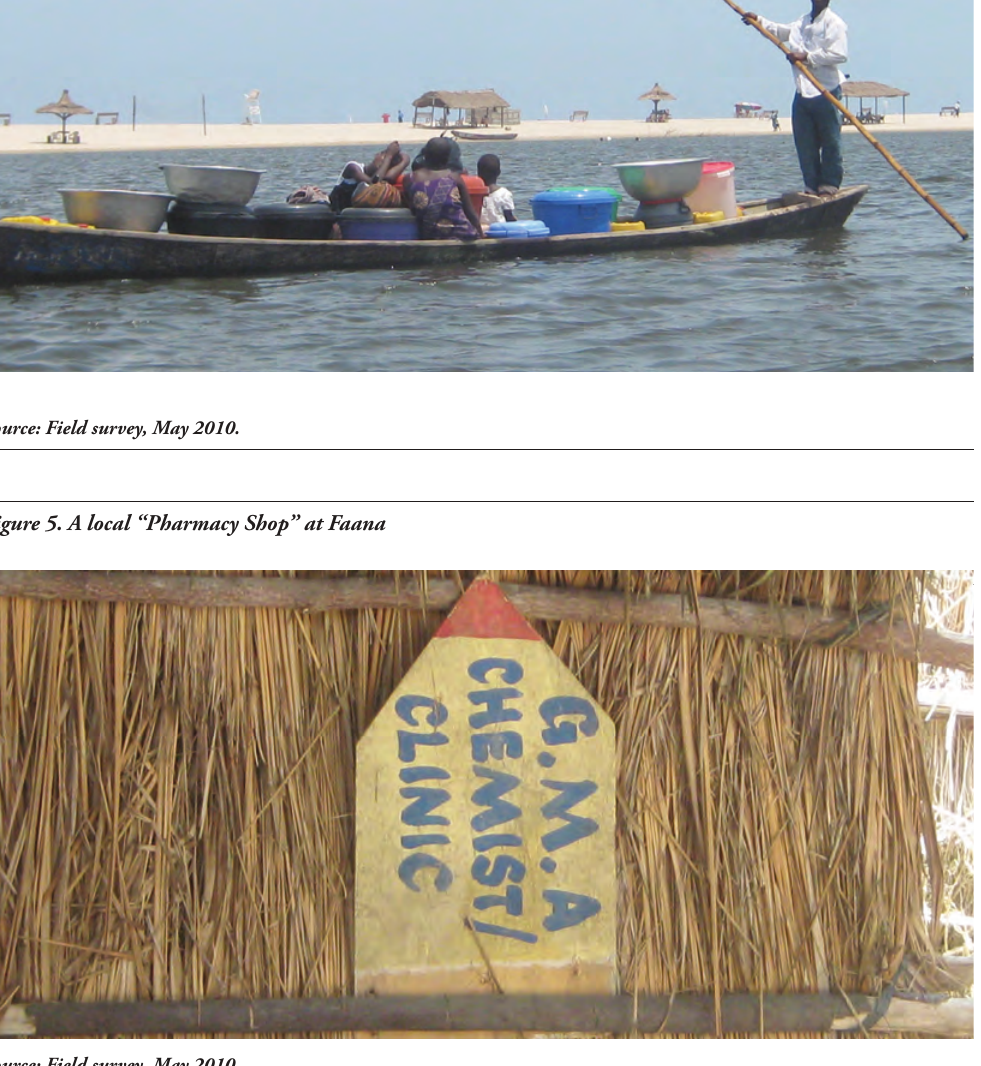
Source: Field survey, May